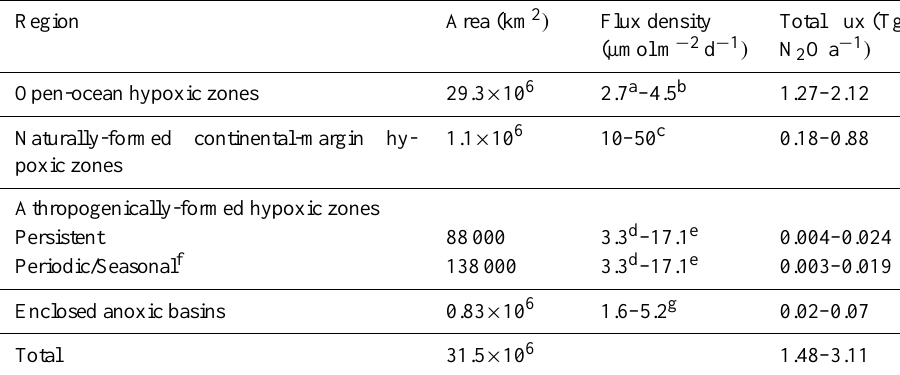
Table 3b. Total N 2 O emissions from various types of marine O 2 -deficient